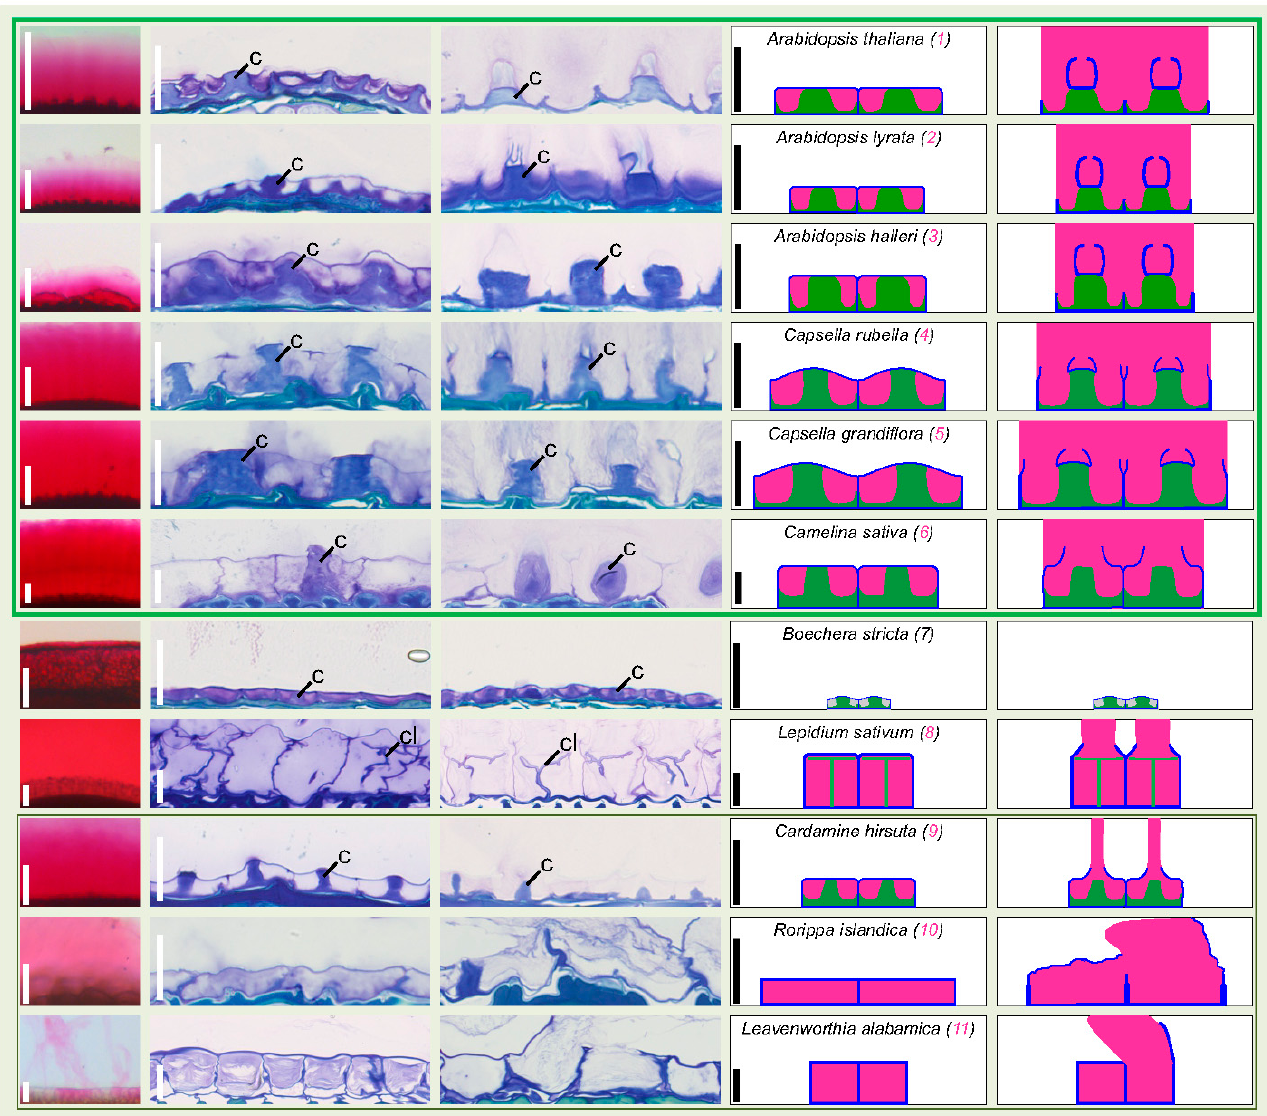
Figure 3. Lineage 1 dry seed MSC morphology is similar to the well-studied A. thaliana MSC morphology in all studied Camelineae species and highly diverse in non-Camelinae species, while the A. thaliana MSC opening mode is restricted to Arabidopsis species. Column 1: magnified view of imbibed seeds stained with ruthenium red (full images are shown in Figure 2) reminds the ability to release mucilage or not. Scale bar: 100 µm. Columns 2 and 3: Toluidine blue histochemical staining of dry seeds and imbibed seeds, respectively, focusing on the outermost cell layer morphology and of mucilage release mode for myxospermous species. Note that the inner part of the seed is located below the imaged cells. Columella (c) and columella-like structure (cl) are labeled. Scale bar: 25 µm. Columns 4 and 5: simplified drawings of two epidermal cells at the same scaling shown in Toluidine blue images. For each line the species name, the species number (pink for myxospermous and black for non-myxospermous species), as well as the scale of cross sections is reminded in column 4. A color code is applied for mucilage (pink), primary wall (blue), columella or columella-like structure (green), intracellular unidentified structures or sublayering (grey).